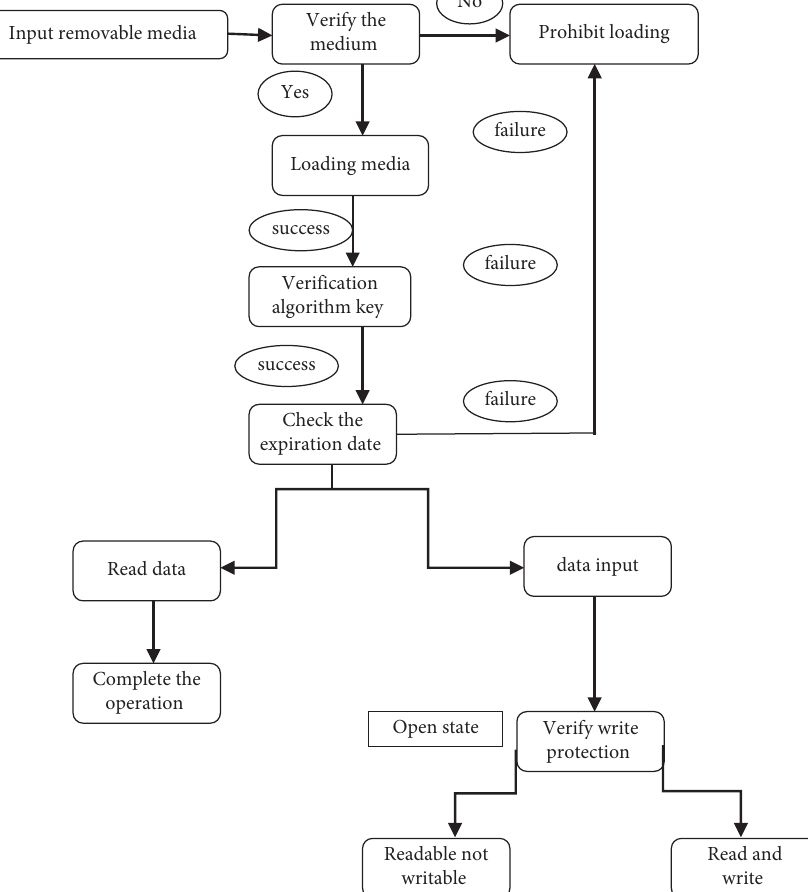
Figure 5: Operation flowchart of mobile media security protection.